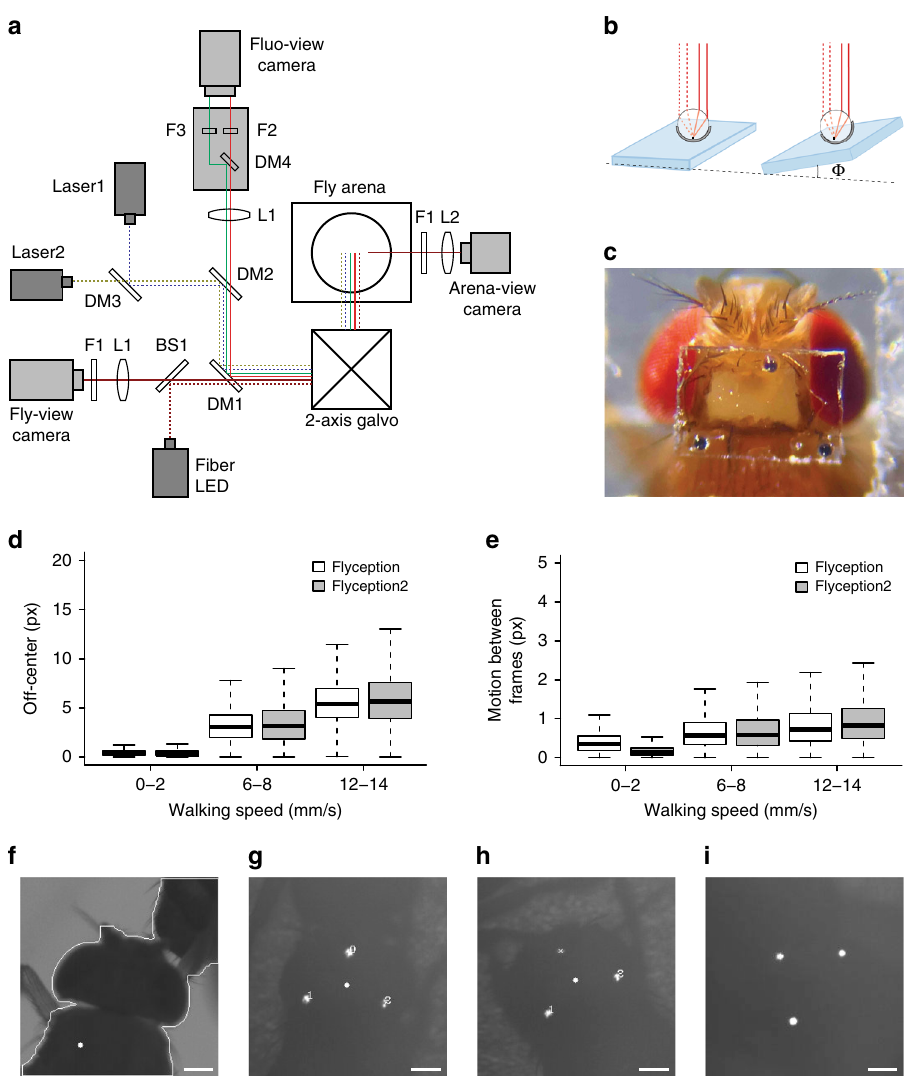
Fig. 1 Retrore fl ector tracking and ratiometric fl uorescence imaging of freely walking fl ies. a Schematic diagram of the tracking and fl uorescence-imaging system. DM1, DM2, DM3, and DM4, dichroic mirrors; F1, F2, and F3, optical fi lters; L1 and L2, lenses. Solid lines shown in red, green, and brown indicate light paths for the red, green fl uorescence, and arena-infrared backlighting, respectively. Dotted blue, yellow, and brown lines indicate light paths for the blue (473 nm), green – yellow (561 nm) laser illumination, and infrared (850 nm) overhead lighting, respectively. Galvo, galvanometer mirror. See Supplementary Fig. 1 for details. b Design and placement of the retrore fl ective marker on the coverslip used in this study. Dotted lines indicate incoming infrared light, and solid lines indicate the retrore fl ected light path back to the tracking camera. The right panel illustrates intact retrore fl ection despite tilting of the coverslip up to ~30°. c A view of the fl y head with a surgically made optically clear brain-imaging window, and a retrore fl ective marker-based coverslip with three markers placed in a triangular pattern. See Supplementary Videos 1 and 2 for coverslip preparation and surgery protocol. d Comparison of head center position differences relative to the center of each fl y-view image frame for different walking speeds under Flyception and Flyception2 tracking. px pixels. e Comparison of positional changes of the fl y head between two consecutive frames in fl y view for different walking speeds under Flyception and Flyception2 tracking. Boxplot whiskers are 1.5× interquartile range. f Flyception fl y outline-based tracker merging contours of two fl ies due to a physical contact event. The white dot represents misidenti fi cation of focal fl y head center position. g Flyception2 retrore fl ective marker-based tracking robustly tracking focal fl y head center position during physical contact with another fl y. h Tracking algorithm estimates the position of a single marker occluded from the tracking camera view, represented by a cross, to maintain the accurate head center position. i Example of intact retrore fl ection from a coverslip titled due to the male fl y engaged in